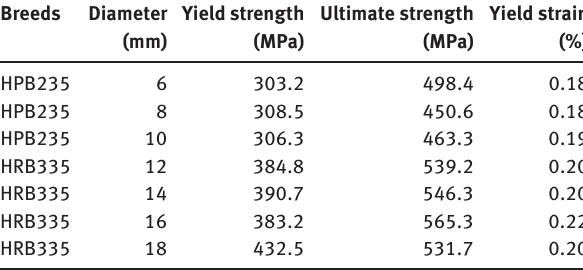
Table 2: The material properties of steel